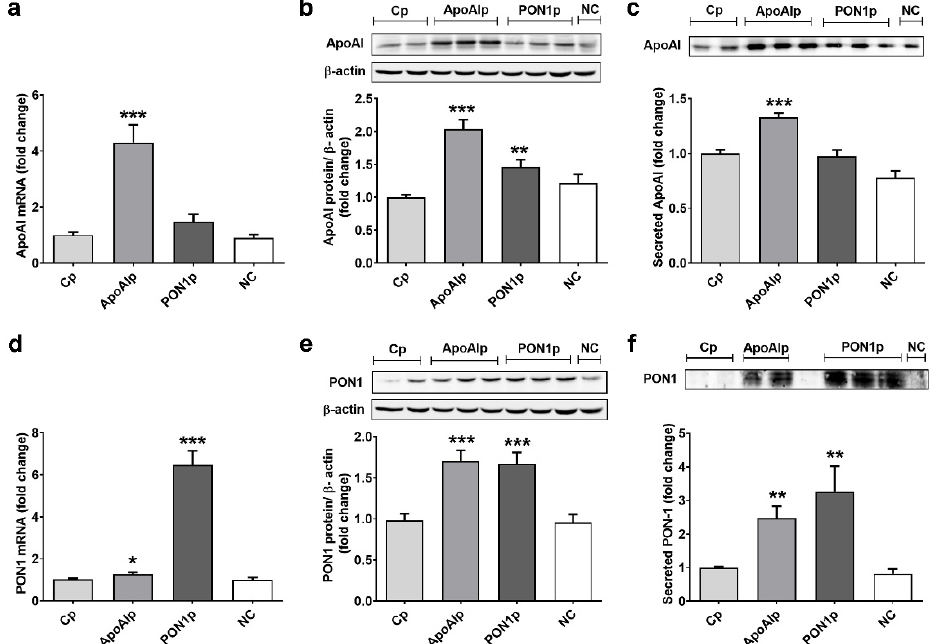
Figure 2. Transcriptional activation of ApoAI and PON1 by CRISPR/dCas9 technology in Caco-2 cells. ( a , d ) ApoAI and PON1 mRNA; ( b , e ) ApoAI and PON1 protein expression relative to β -actin (representative blot and densitometric analysis); ( c , f ) secreted ApoAI and PON1 in the culture medium relative to total cell protein (representative blots and densitometric analysis). Cp, control CRISPR activation plasmid; ApoAIp, CRISPR activation plasmids for ApoAI; PON1p, CRISPR activation plasmids for PON1; NC, negative control–untransfected Caco-2 cells. All data are expressed as fold change versus Cp and presented as mean ± SEM of 3–5 independent experiments. * p < 0.05, ** p < 0.01, *** p < 0.001 vs. Cp.